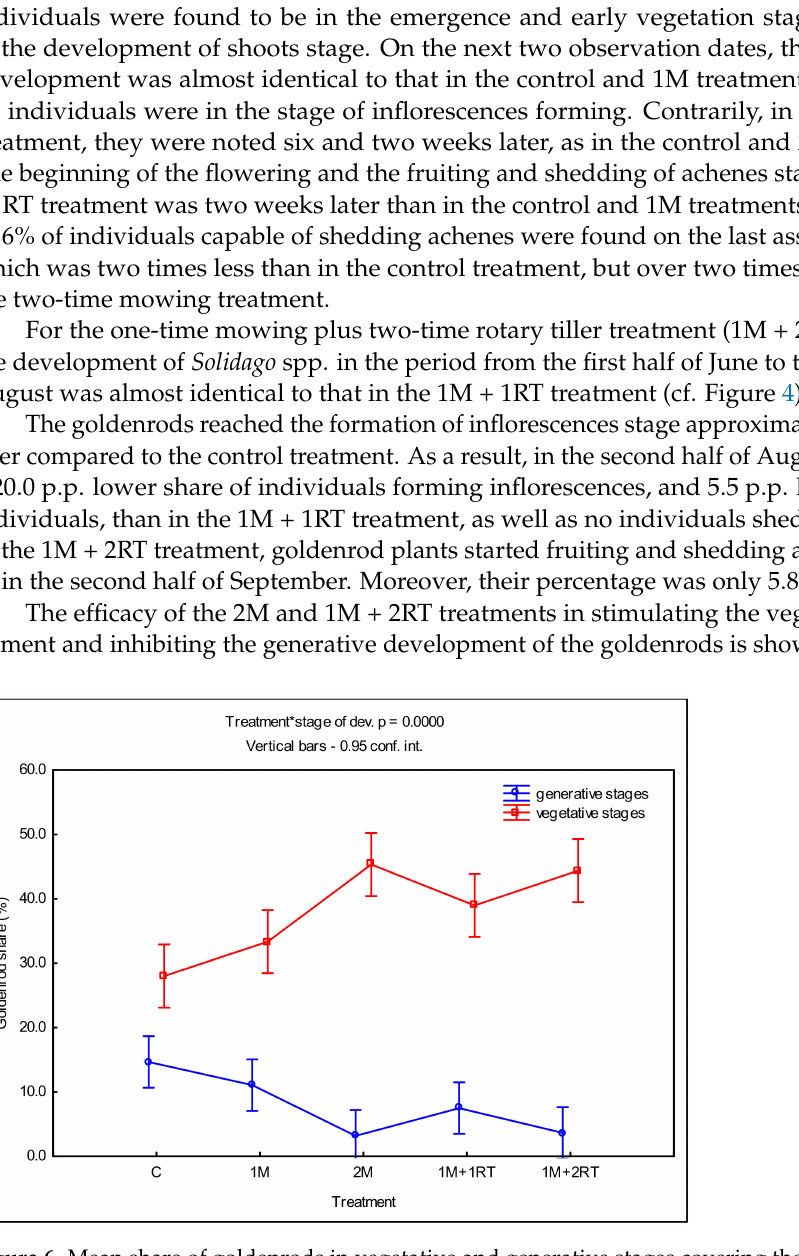
Figure 6. Mean share of goldenrods in vegetative and generative stages covering the plots’ surfaces, depending on the type of mechanical treatment. The following symbols denote the research treat- ments: C: control; 1M: one-time mowing; 2M: two-time mowing; 1M + 1RT: one-time mowing with one-time rotary tilling; 1M + 2RT: one-time mowing with two-time rotary